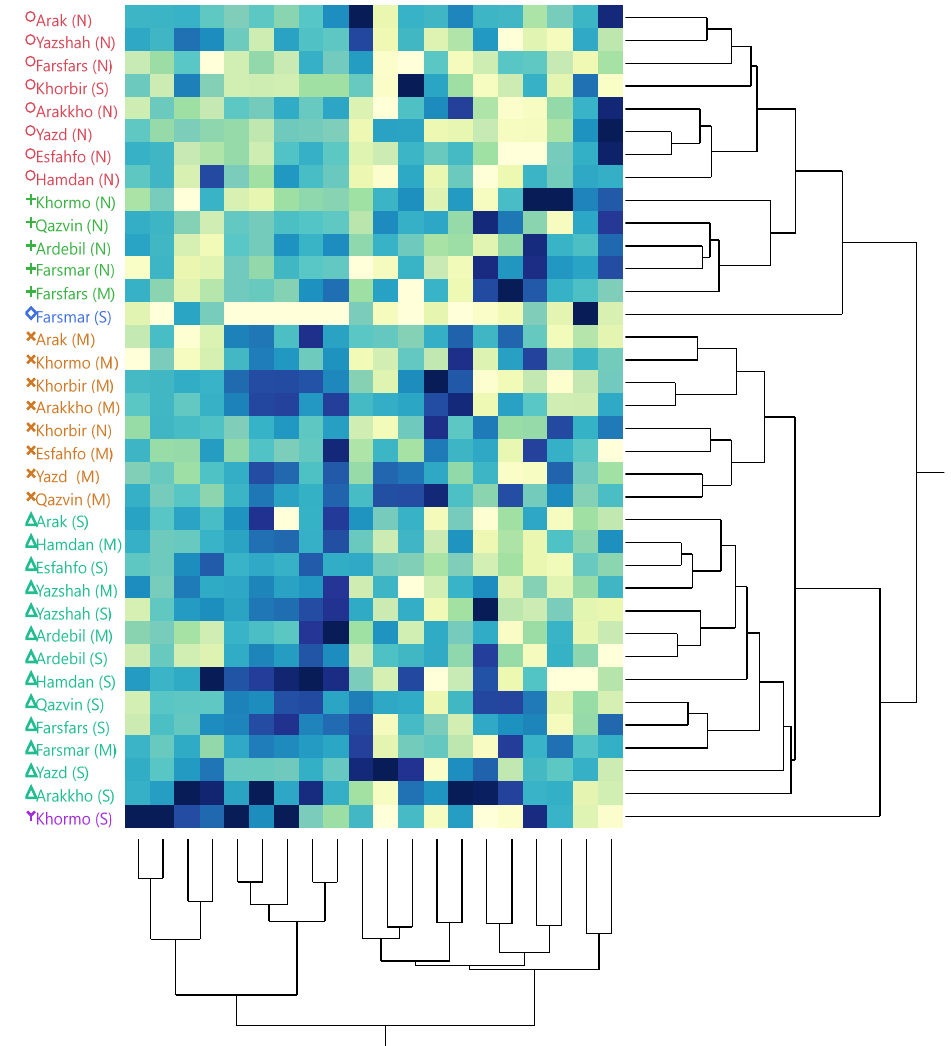
Figure 5. Hierarchical clustering analysis (HCA) of 12 ajowan populations based on oil content, HPLC, and GC–MS compounds in three water deficit levels.